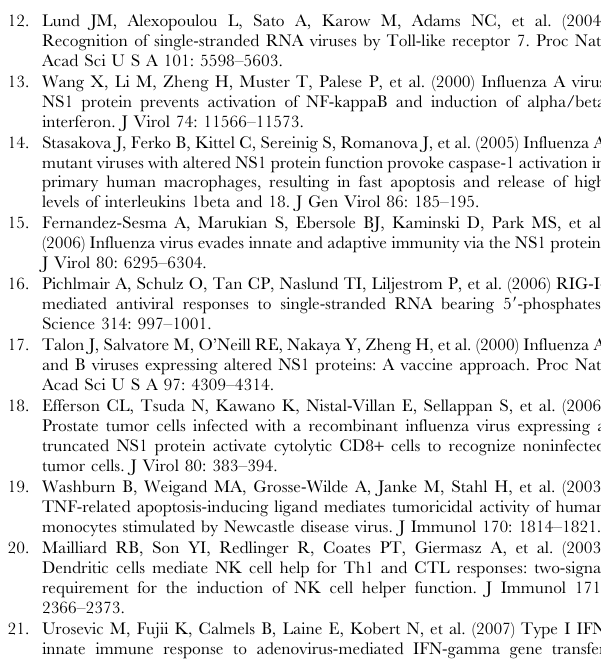
Figure S1 Influenza A delNS1 does not induce tumor lysis.